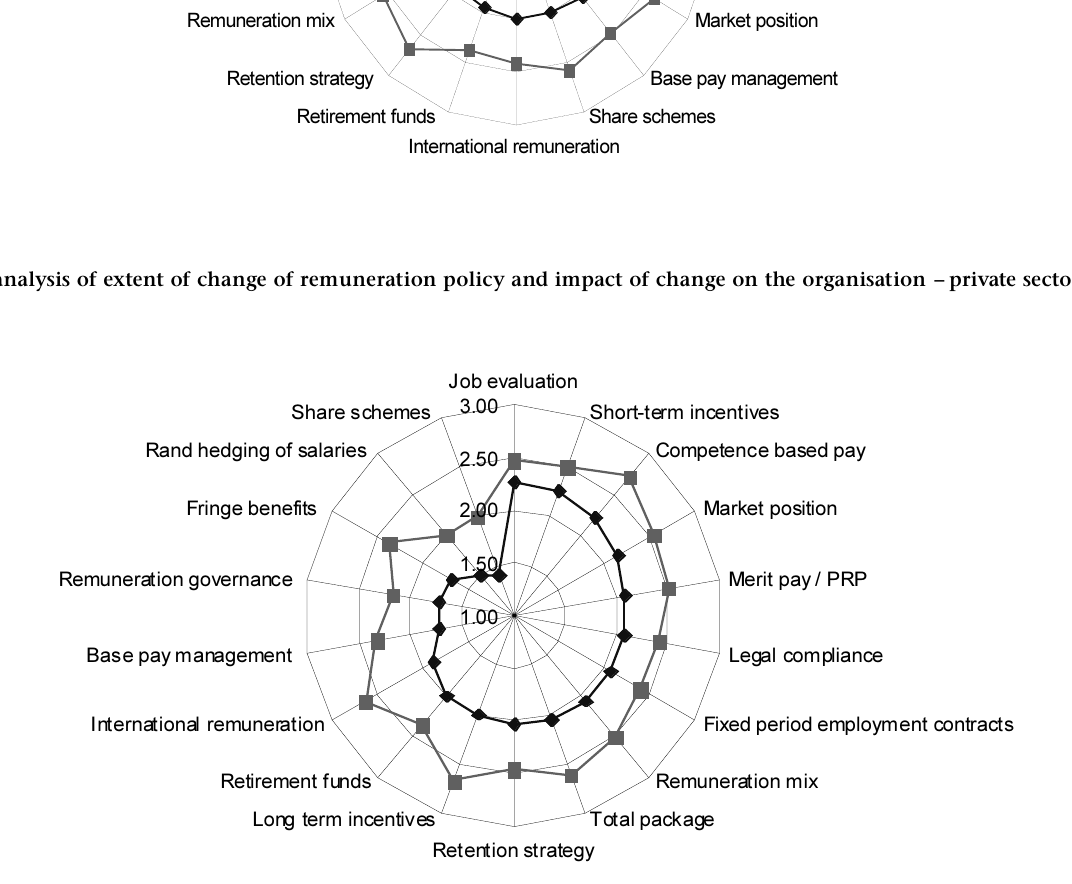
Figure 3: Gap analysis of extent of change of remuneration policy and impact of change on the organisation – public